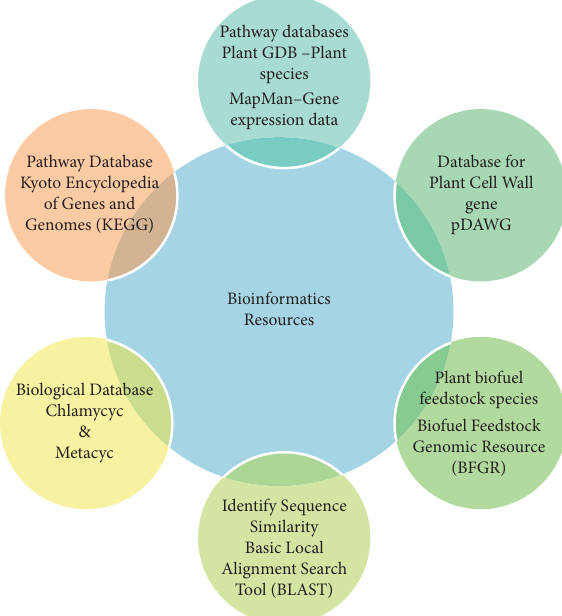
Figure 3: Establishment of bioinformatics in microbial fuel cells